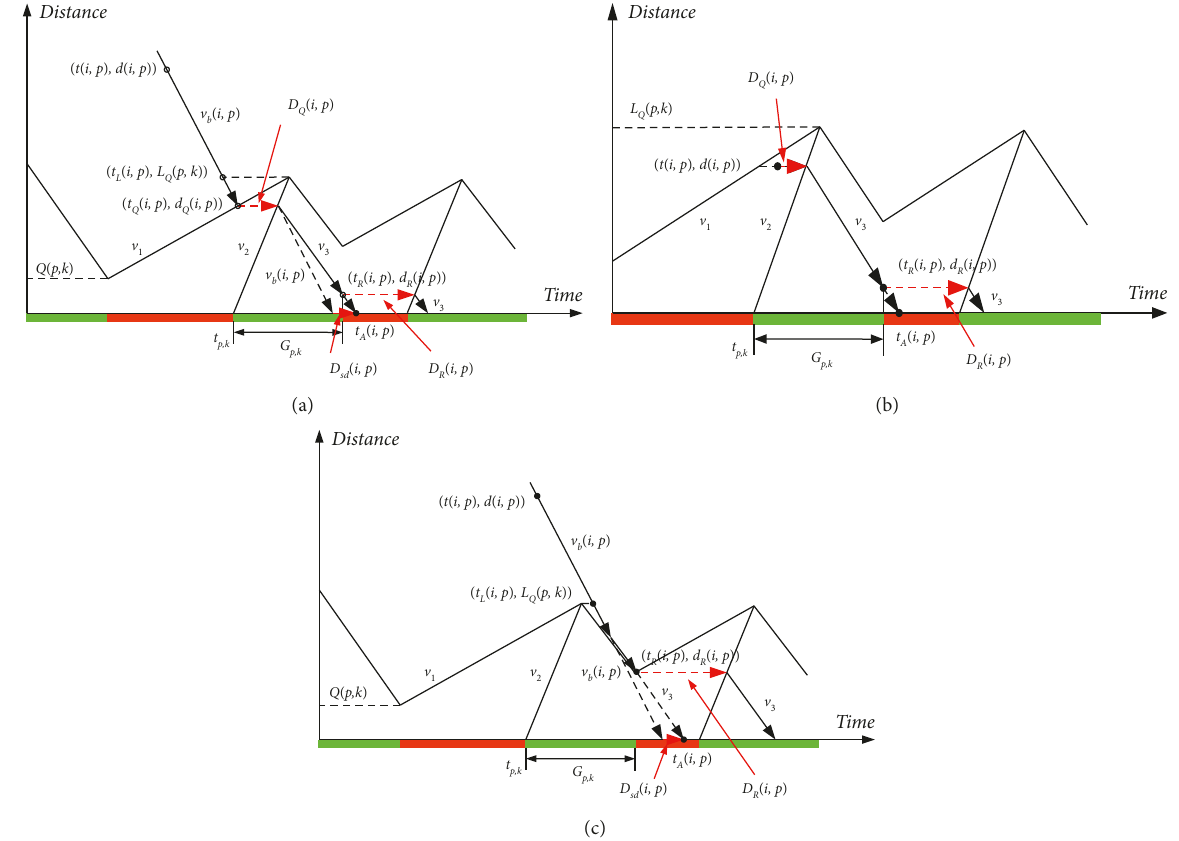
Figure 3: Illustration of the possible process of a HOV passing the intersection: (a) HOV passing the intersection experiencing three parts of delay (b) A stopped HOV passing the intersection (c) HOV passing the intersection without queuing